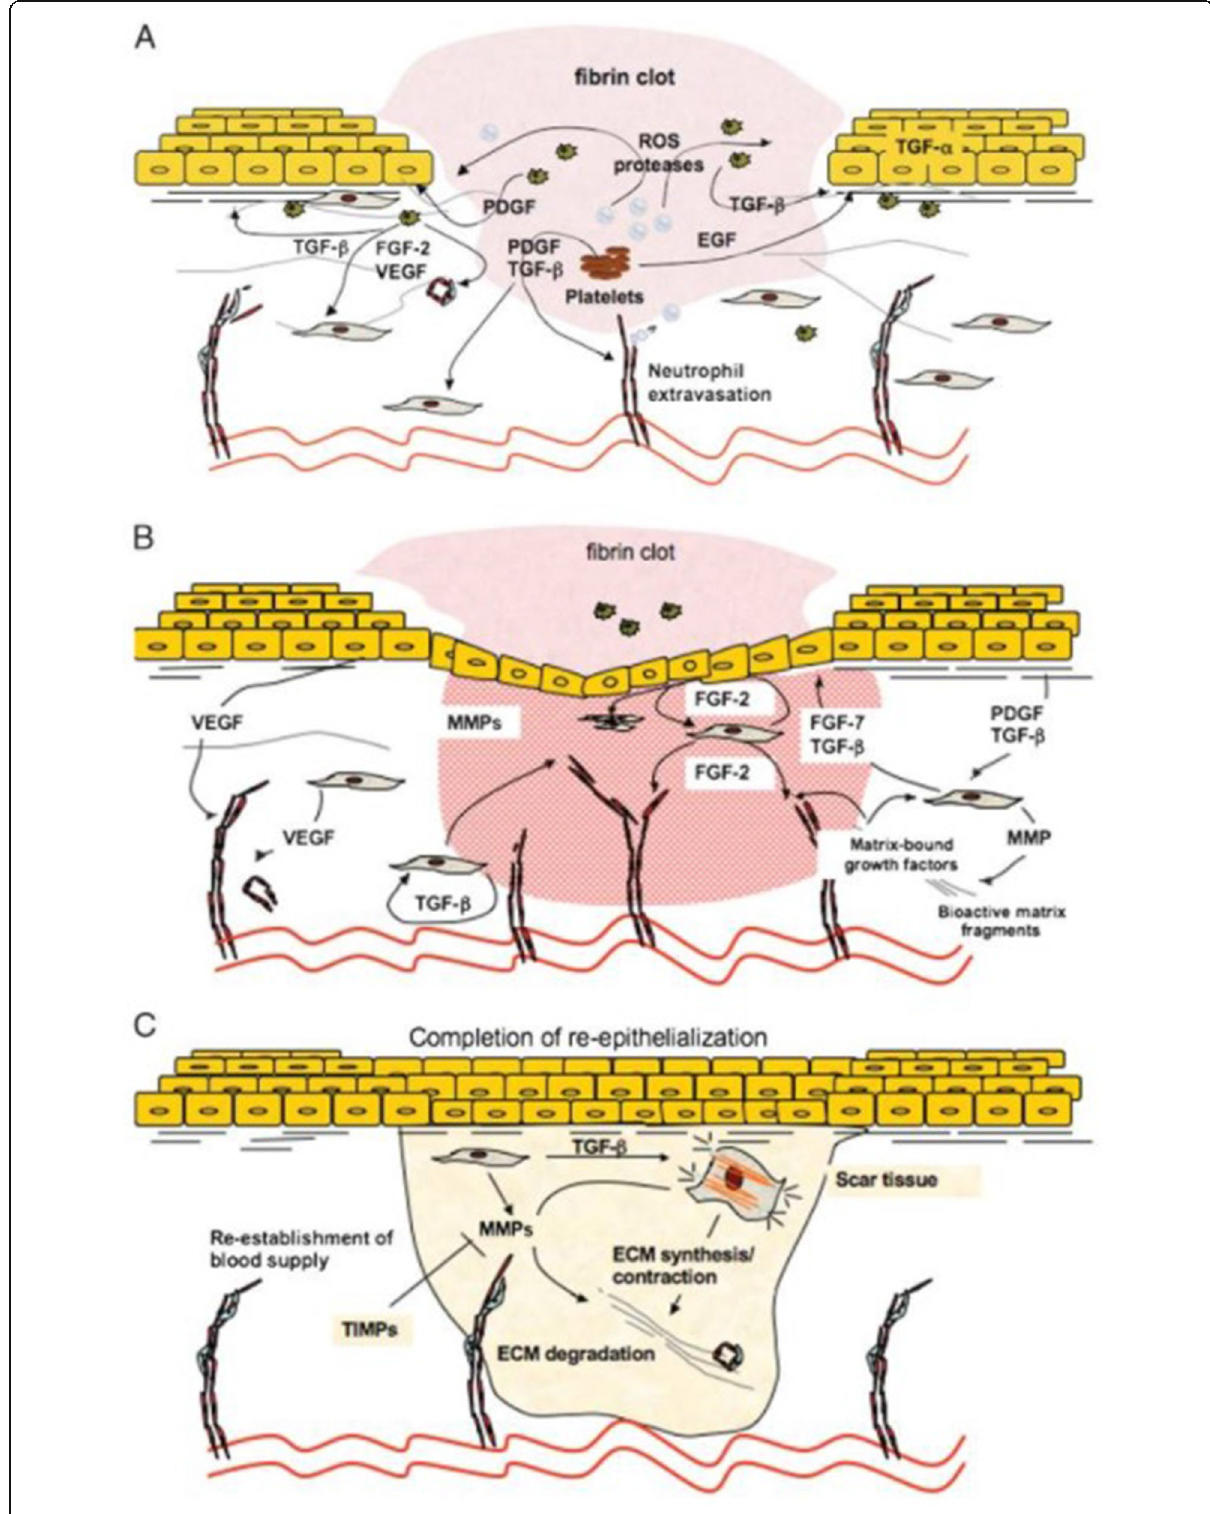
Fig. 1 Different phases of wound healing (adapted from reference